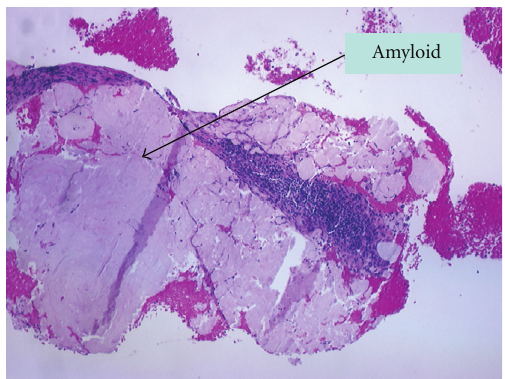
Figure 1: CT guided lung biopsy showed H&E (hematoxylin and eosin) and PAS (periodic acid-schi ff ) positive amorphous eosinophilic material suspicious for amyloid. Initial staining with congo red was negative. However, it stained positively with Thioflavin T stain and had weak green birefringence under polarized light.